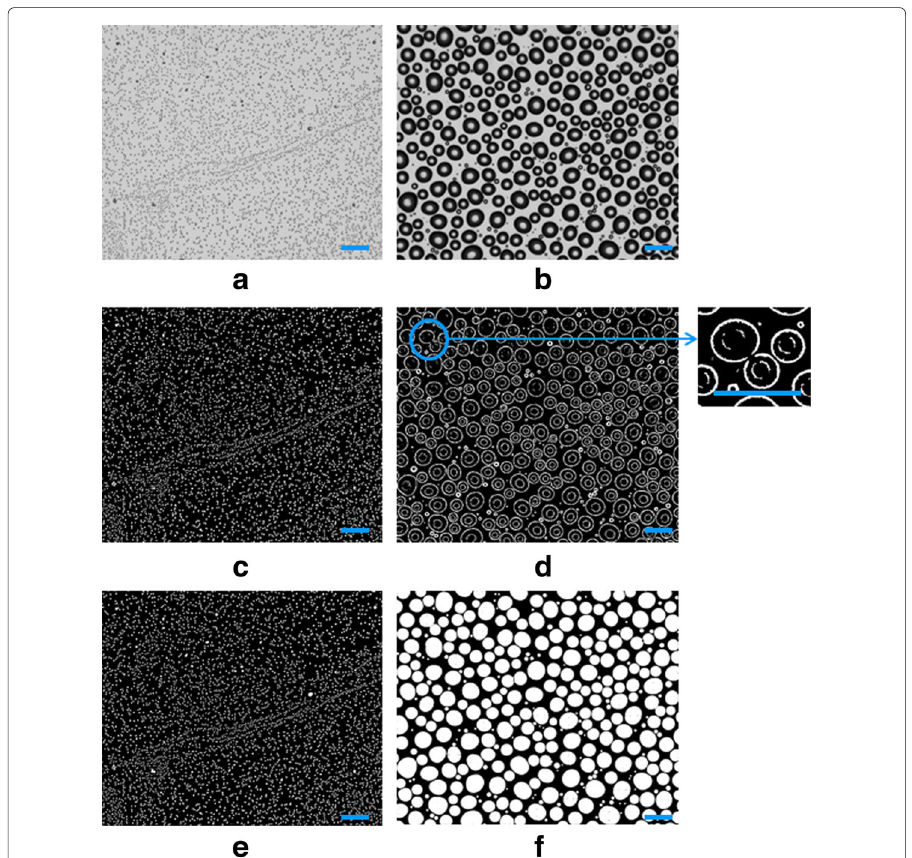
Fig. 3 Exemple pictures of a condensation test illustrating the use of the two droplets detection programs. Exemple pictures of a 45% relative humidity level, 30 ◦ C air temperature and 1 ◦ C subcooling condensation test illustrating the use of the two droplets detection programs. a , c , e are respectively the raw images, the enhanced droplet profiles and the final binary images obtained with the first program. b , d , f are respectively the raw images, the enhanced droplet profiles and the final binary images obtained by the second program. The scale bar represents 320 μ